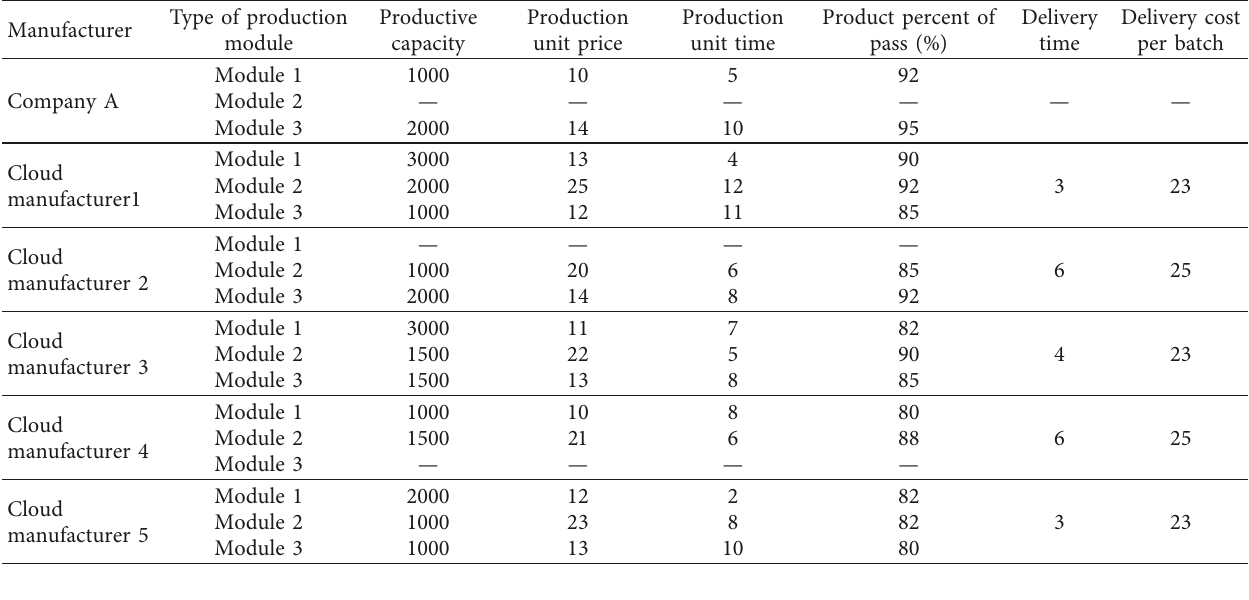
Table 5: A enterprise and manufacturers on cloud platform.